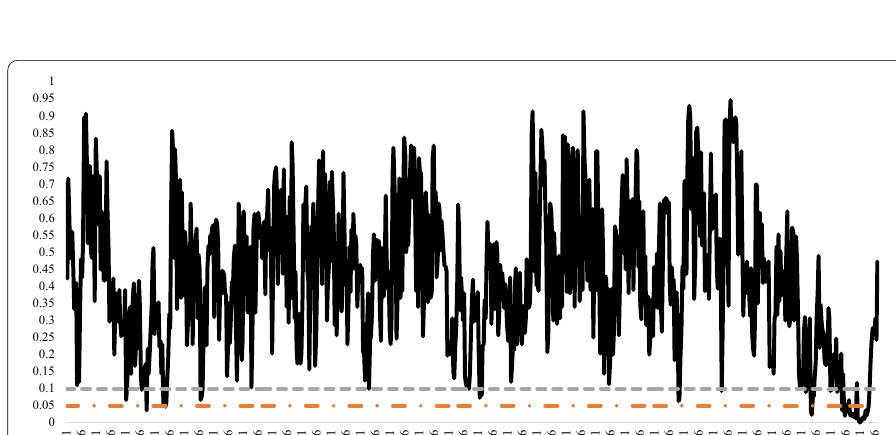
Fig. 33 The evolving p values of the GS test statistic checked for the WTI in 100-day window length